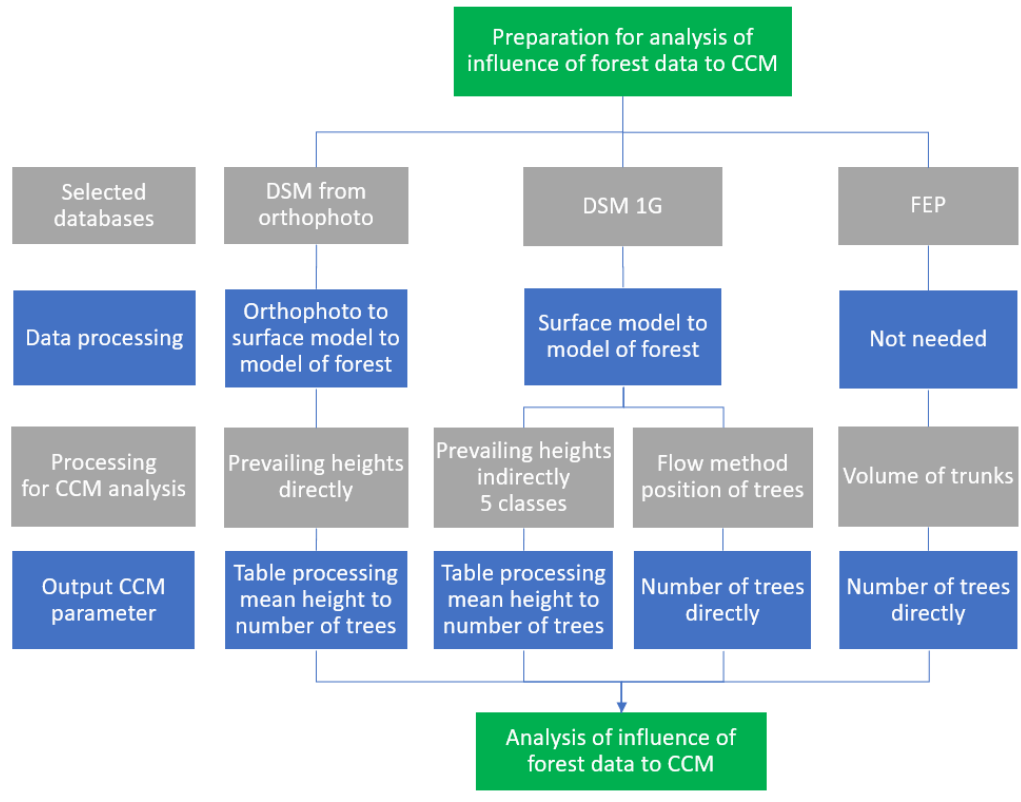
Figure 1. Methodological steps of processing selected databases and preparing them for cross-country mobility (CCM) analysis.